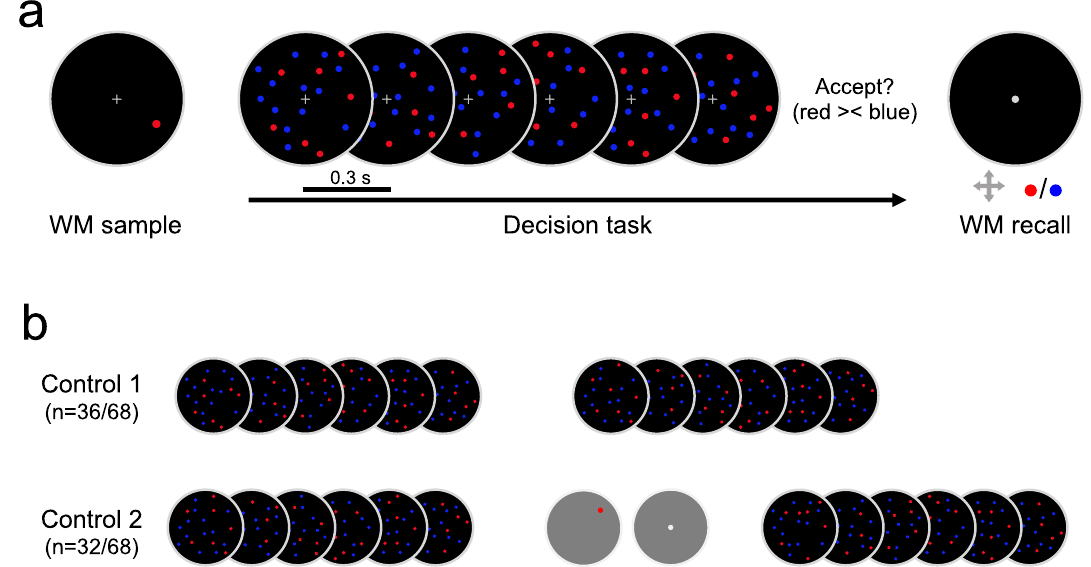
Figure 1. Experimental paradigm. ( a ) Schematic outline of a trial in the WM interference condition. Left , the to-be-maintained WM sample was a single dot (red or blue) presented at a random position on an invisible circular path around fixation. Middle , During WM maintenance, a stream of 6 random dots displays was presented. Each display contained 20 dots, a variable number of which was blue, the others red. Participants were asked to evaluate whether the stream contained relatively more blue or red dots (see “Methods” for details). Right , both the color and location of the WM sample were to be reproduced from memory at the end of the trial. ( b ) Within-subjects control conditions. In Control 1, the WM task elements were omitted. In Control 2, the WM- and decision task elements were rearranged such that the two tasks were not